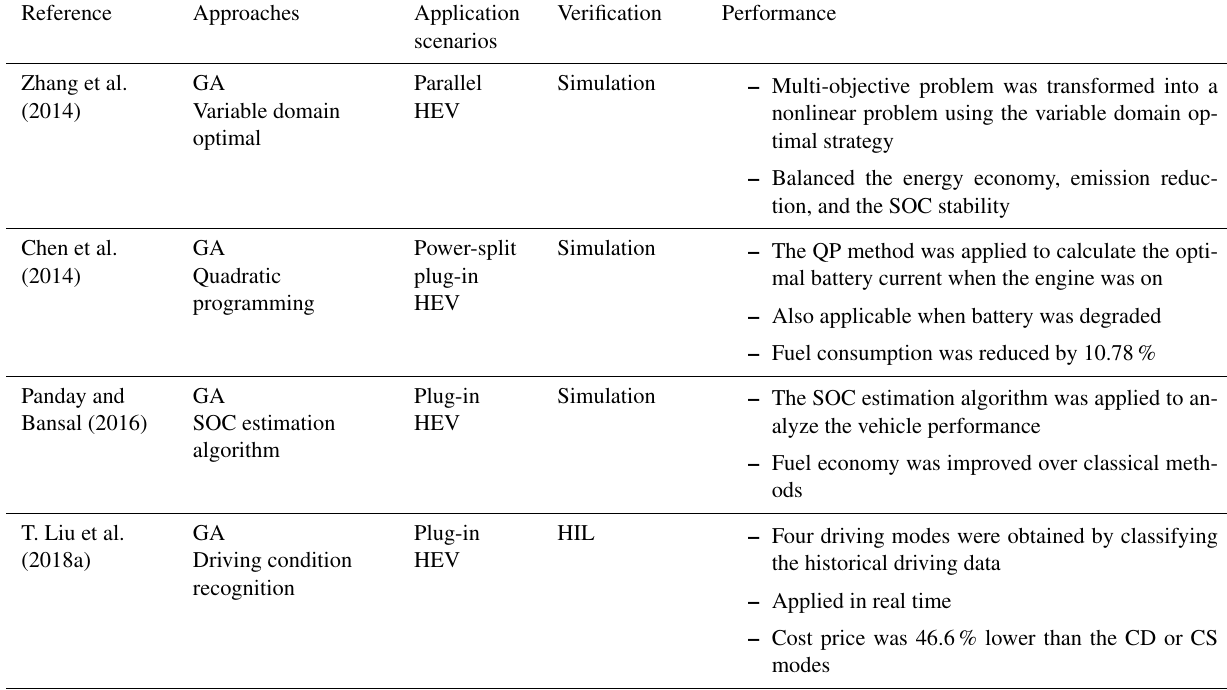
Table 7. Summary of exemplary works on GA-based EMSs.